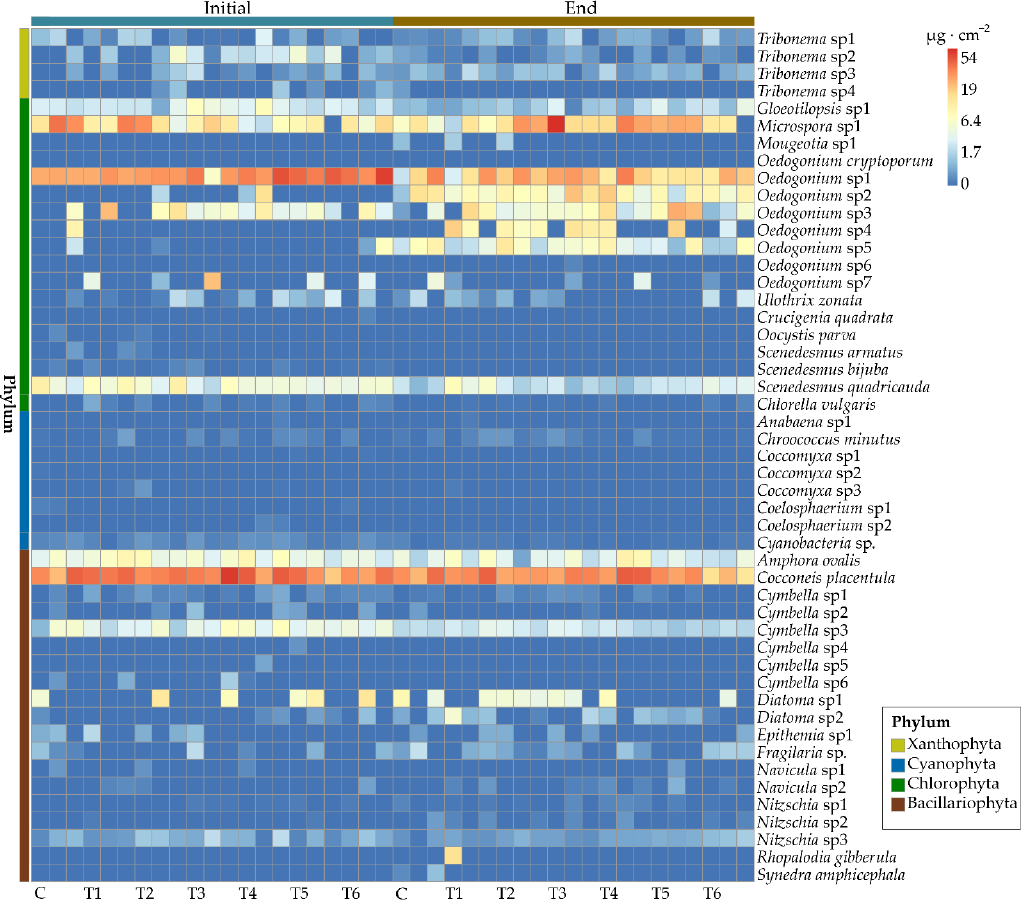
Figure 4. Heatmap of epiphytic algal species biomass. The color of the square indicates the level of the biomass. Each group has three replications. Abbreviations for groups are the same as in Figure 1.